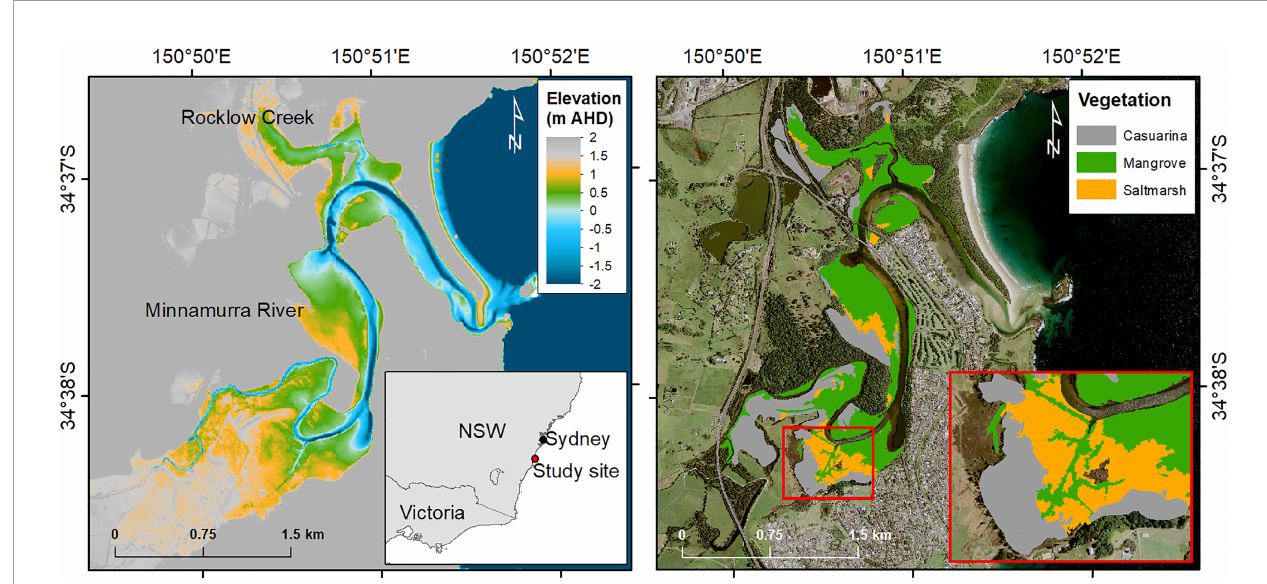
FIGURE 1 | Bathymetry and topography of Minnamurra River estuary (left), and intertidal wetland vegetation communities (right). Lidar-derived topography and sonar-derived bathymetry sourced from Geoscience Australia (2018; 2011), Department of Planning Industry and Environment (2017) and University of New South Wales (2017). Wetland mapping adjusted from Owers et al. (2016) and Chafer